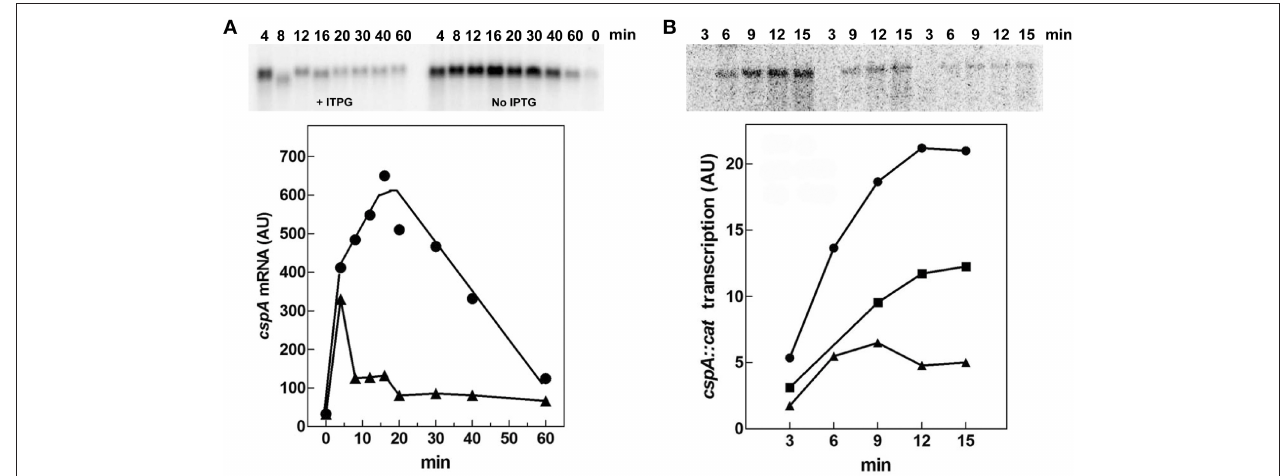
FIGURE 6 | (p)ppGpp negatively affects cspA transcription. (A) The steady state levels of cspA transcript were determined during growth in Phosphates-free medium at 37 ◦ C in cells overproducing or not (p)ppGpp. Total RNA was extracted from cells in stationary phase (time zero) and at the indicated times after dilution with fresh medium alone ( (cid:8) ) or supplemented with 400 µ M IPTG ( N ). The levels of cspA mRNA were estimated by Northern blotting analysis. (B) Effect of (p)ppGpp on the in vitro activity of cspA promoter. The transcriptional activity was estimated in the absence ( (cid:8) ) or in presence of 200 ( (cid:4) ) and 400 µ M ( N ) of (p)ppGpp. Reactions and processing of samples were performed as described in Materials and Methods. The supercoiled plasmid pKK310:: cat used as DNA template was pre-incubated with (p)ppGpp and RNA polymerase for 5min at 37 ◦ C. Then reactions were started by adding NTPs at a final concentration of 100 µ M each. At the indicated incubation times, aliquots were withdrawn and transcription stopped with EDTA (f.c. 30mM). Quantization of the Northern blots (upper panels), expressed as Arbitrary Units (AU), is plotted as a function of time (lower panels).